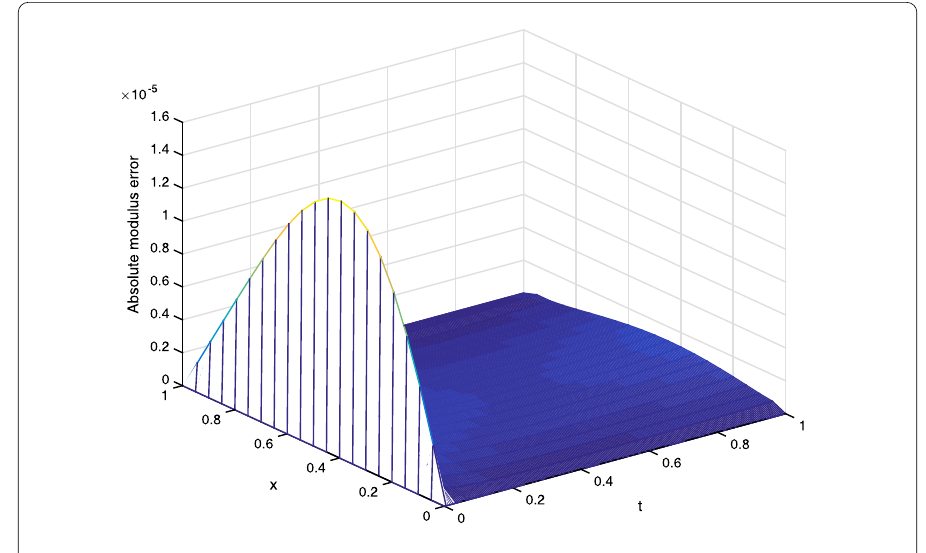
Figure 4 (Example 6.2) Absolute modulus